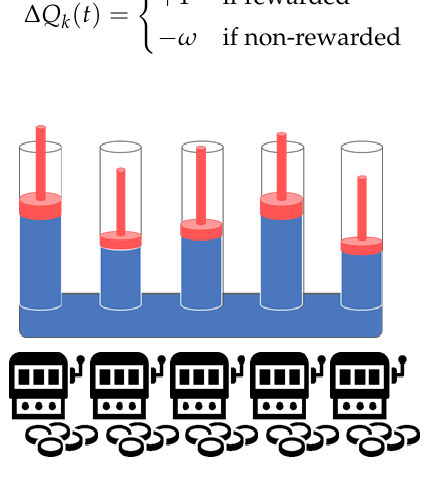
Figure 3. tug-of-war (TOW) dynamics for n -machine